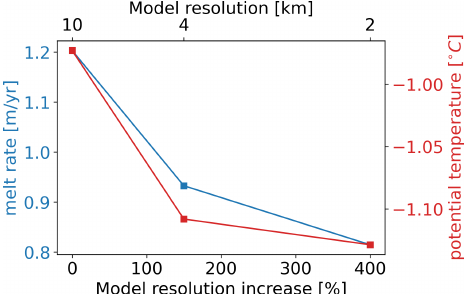
Figure 4. Grid convergence. Annual means of average melt rate and continental shelf potential temperature resolved at the differ- ent horizontal resolutions: 10km (0% increase), 4km (150% in- crease), and 2km (400% increase). Continental shelf temperatures have been calculated for depths shallower than 1500m and includ- ing the ice shelf cavities (see Fig. 1). Continental shelf processes converge when grid spacing is